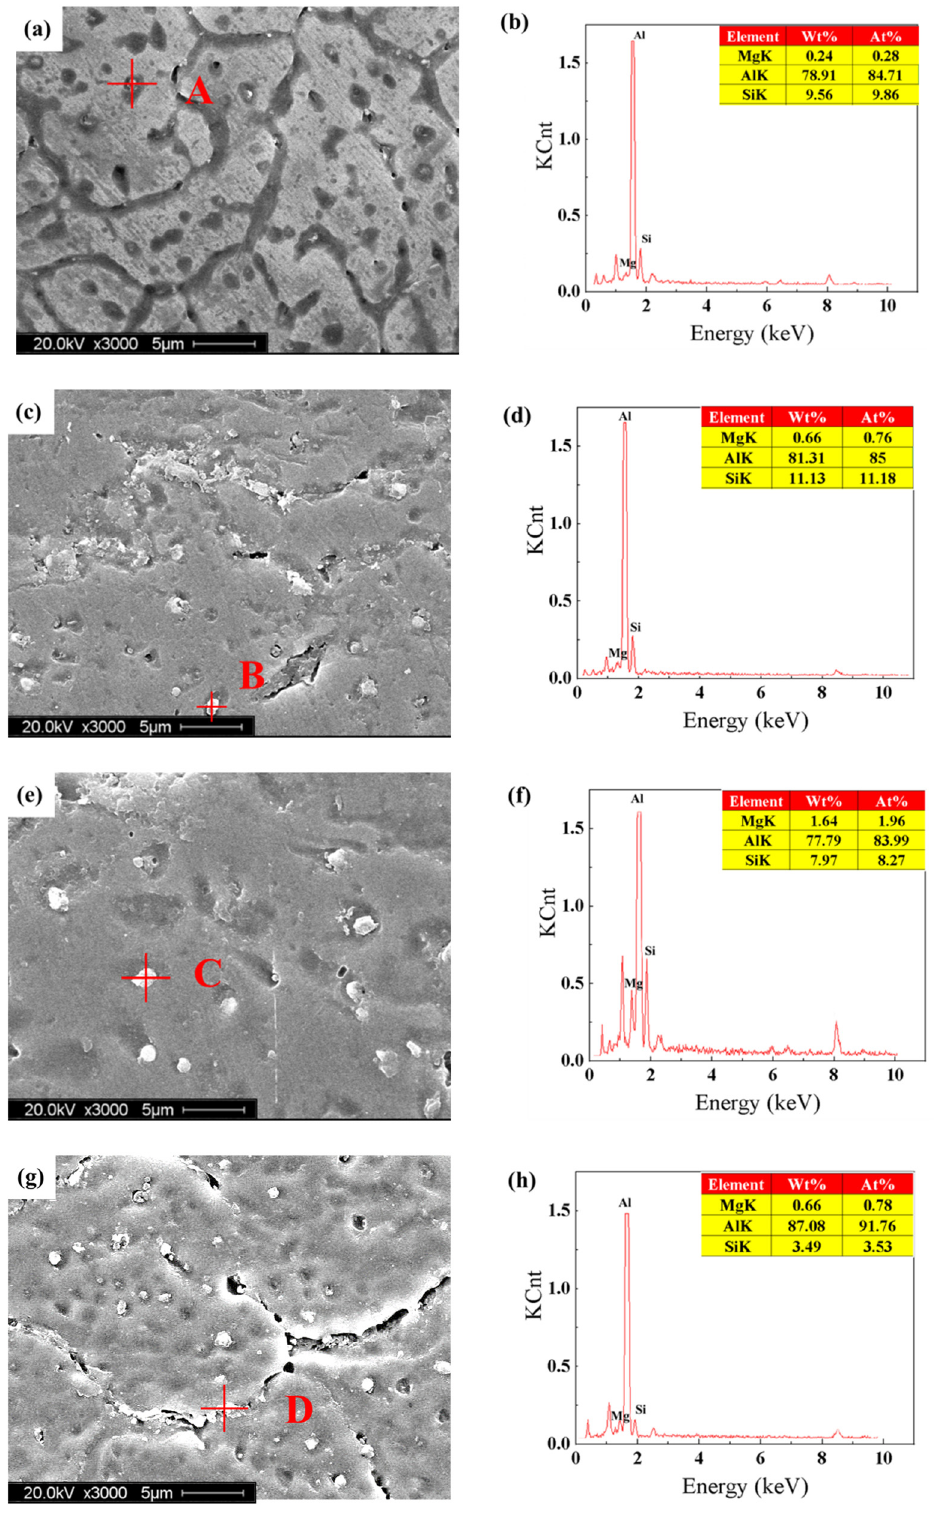
Figure 5: SEM images and EDS analyses of FZ under di ff erent conditions: ( a ) SEM image of FZ in AW joint, ( b ) EDS analysis of point A, ( c ) SEM image of FZ in HT1 joint, ( d ) EDS analysis of point B, ( e ) SEM image of FZ in HT2 joint, ( f ) EDS analysis of point C, ( g ) SEM image of FZ in HT3 joint, and ( h ) EDS analysis of point